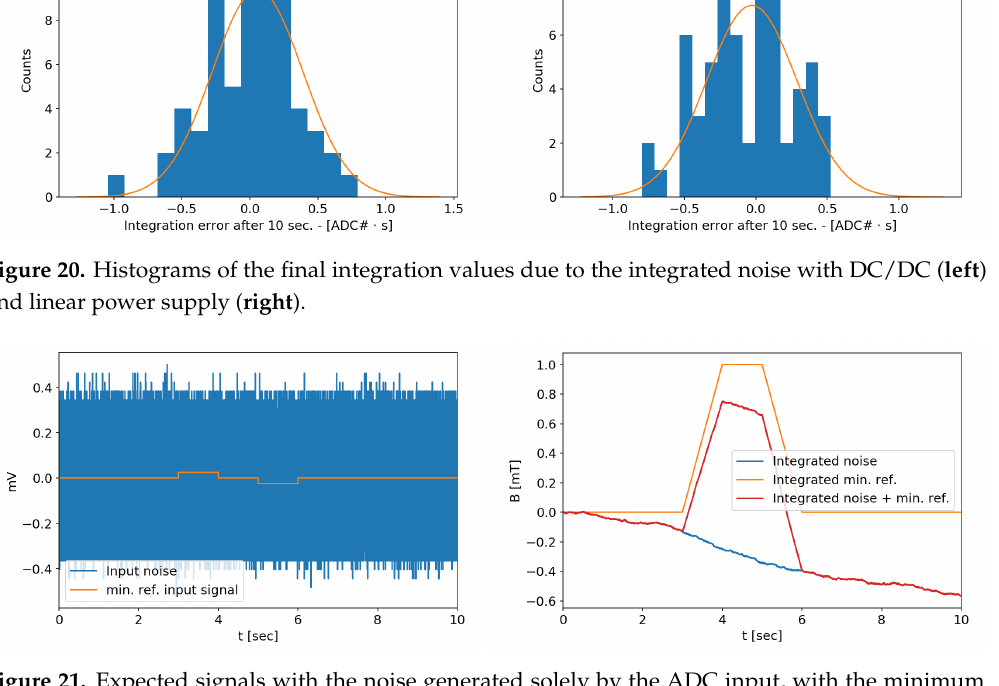
Figure 21. Expected signals with the noise generated solely by the ADC input, with the minimum reference input signal. The integrated signal is clearly